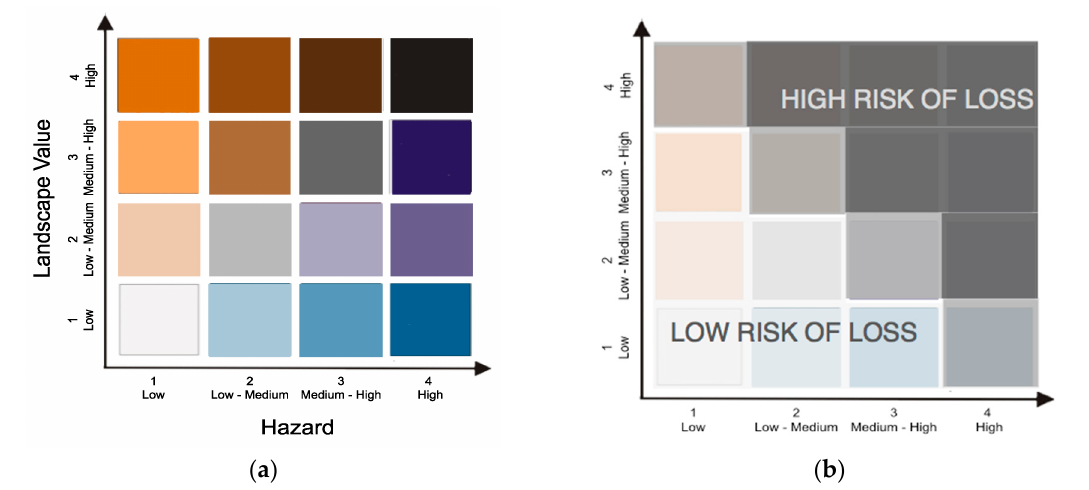
Figure 8. MEDSCAPES risk assessment (LRA) matrix: ( a ): Color code legend of the LRA; ( b ): Dark colors = High risk of loss, Light colors = low risk of loss.